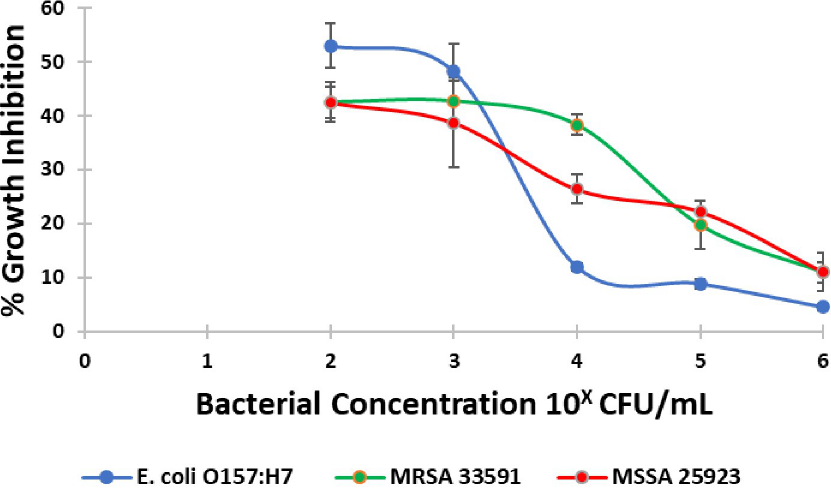
Fig 3. Growth inhibition activity of L . enzymogenes CFS against MSSA, MRSA and E . coli O157: H7 at different concentrations (10 2 , 10 3 , 10 4 , 10 5 and 10 6 CFU/mL).